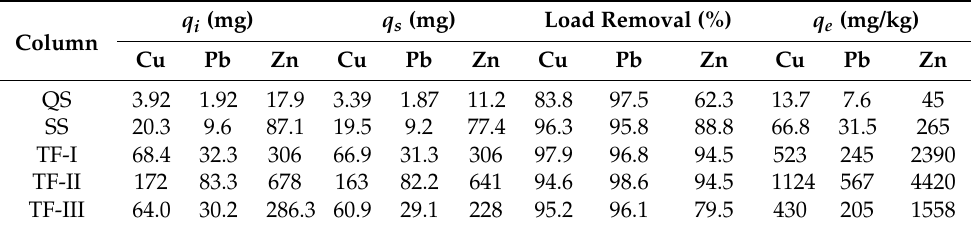
Table 5. Removal efficiencies and sorption capacity of each filter column at filter media exhaustion for Cu, Pb and